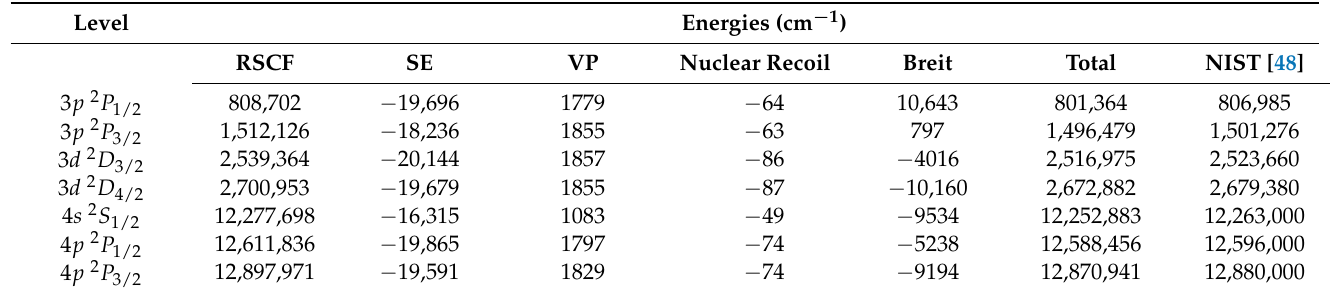
Table 4. The contributions from QED (SE + VP ) effects, Breit interaction and nuclear recoil correction on energies (cm − 1 ) of low lying states of Xe 43 + and the comparison of total energy with the NIST [48] values. The level energies are given relative to the ground